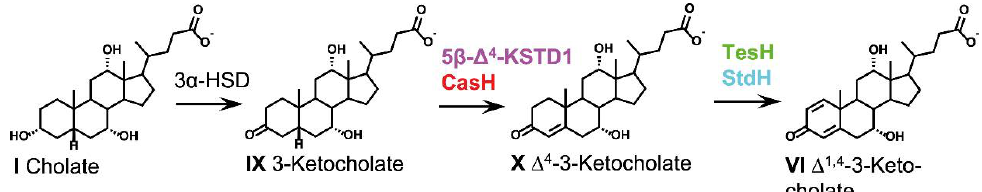
Figure 3. A-ring oxidation as phase 1 of bacterial bile acid degradation. For bile acids, the respective deprotonated bile salts are depicted. Text colors indicate the organism, in which the respective enzyme has been identified: light blue, P. putida DOC21; green, C. testosteroni TA441; red, R. jostii RHA1; magenta, Sphingobium sp. strain Chol11.